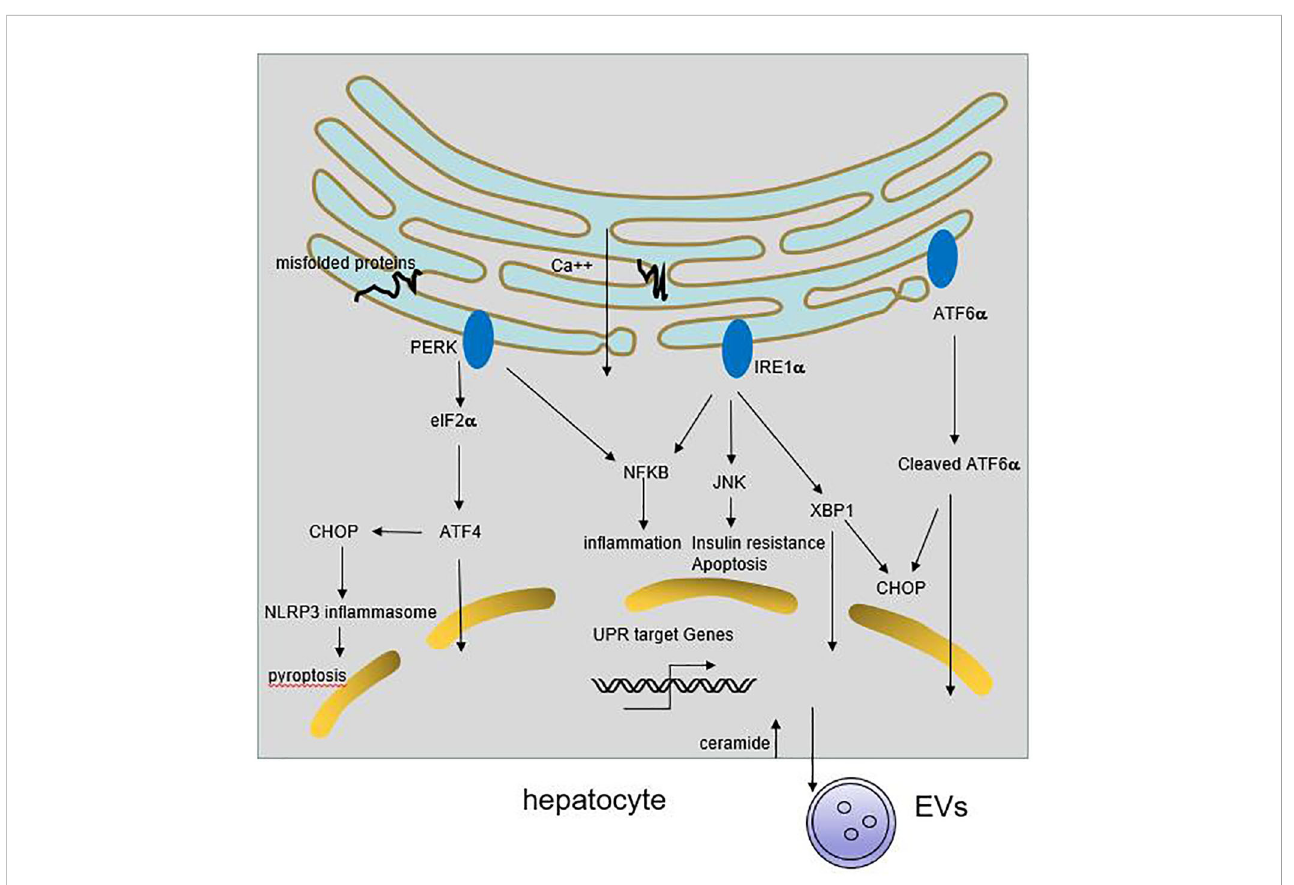
FIGURE 1 Role of ER stress in liver in fl ammation. Multiple stimuli lead to the activation of UPR response in hepatocyte. The three ER transmembrane sensors, PERK, IRE1 and ATF6, coordinately through downstream signaling cascades to resolve the protein folding defect and promote cell survival. If the adaptive UPR is overwhelmed by sustained or massive ER stress, it leads to hepatocyte steatosis and death. Meanwhile, ER stress may trigger NF k B and JNKs activation, resulting in release of proin fl ammatory cytokines. On the other hand, ER stress can induce CHOP-dependent NLRP3 in fl ammasome activation in hepatocytes. Besides, activation of IRE1A in hepatocytes promotes the release of in fl ammatory extracellular vesicles (EVs), thereby accummulating immune cells in fi